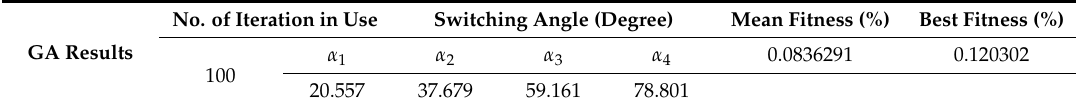
Table 3. Results of switching angle obtained from GA toolbox.